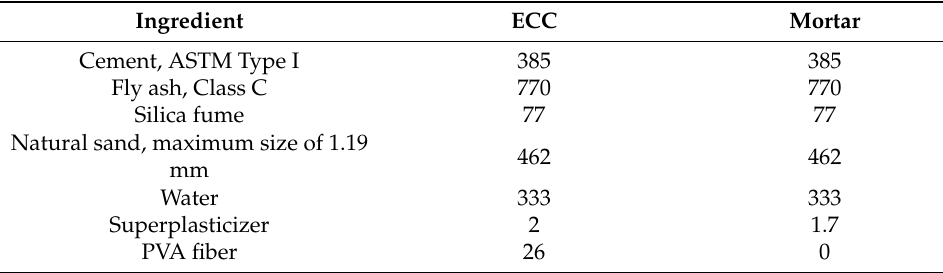
Table 1. Mixture proportions of ECC and mortar (kg/m 3 ). Ingredient ECC Mortar